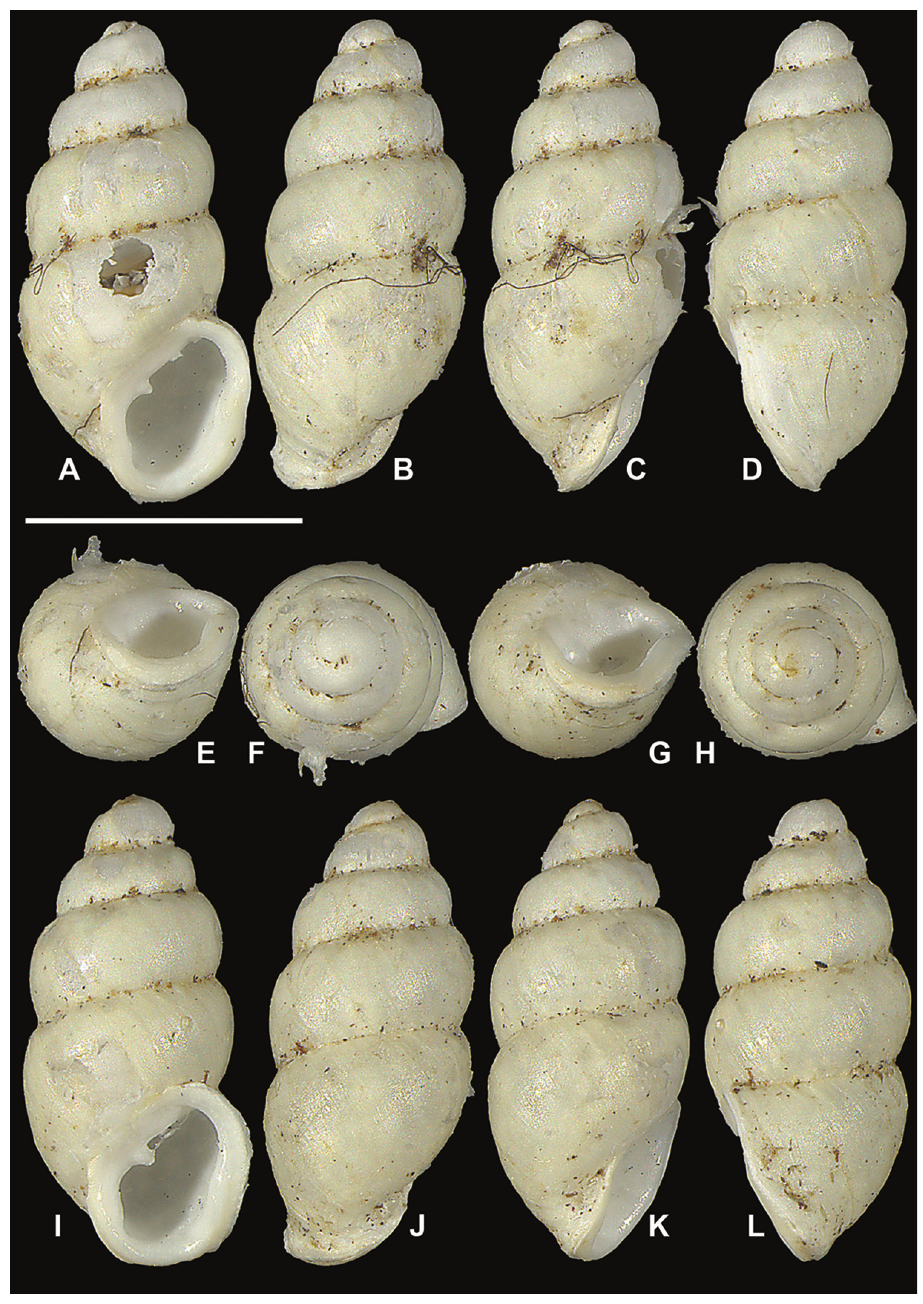
Figure 13. Carychium zarzaae sp. n. A–F holotype (NMBE 549926/1) G–L paratype shell (NMBE 549927/1). Scale bar 1